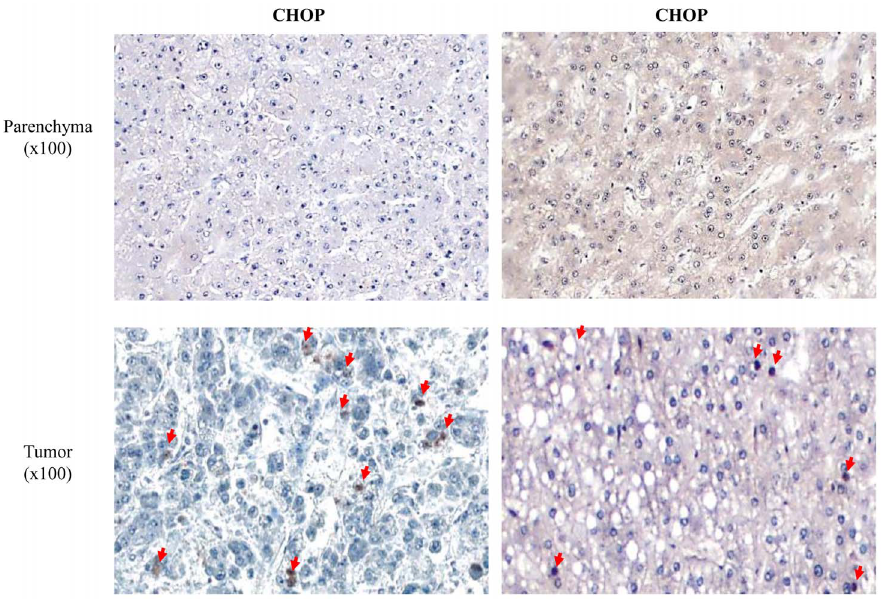
Figure 2. Nuclear CHOP in observed in human HCC. Human samples were stained for CHOP, nuclei were visualized by hematoxylin staining (red arrows).